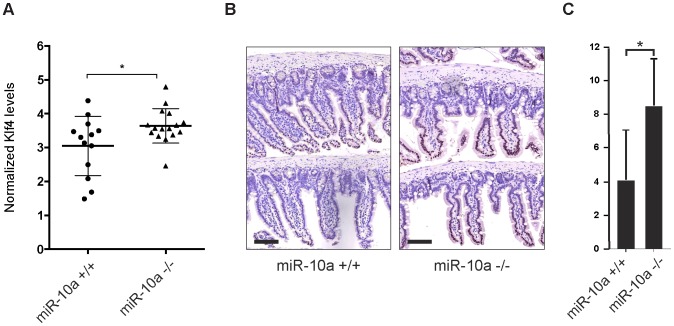
Klf4 is upregulated in miR-10a KO intestines.(A) mRNA levels of Klf4 were measured by qRT-PCR, Actb, Ubc, Hprt and 36b4 were used for normalization. Data are shown as mean ± S.D. of miR-10a KO (n = 16) and WT (n = 13) samples relative to an average of the controls. * p<0.05 using a Mann-Whitney test. (B) Representative immunohistochemistry staining of Klf4 in miR-10a WT (n = 5) and KO (n = 8) intestine. Scale bar 100 µm (C) VisiomorphDP software scoring of Klf4 expression level estimated by distribution and staining intensity in Klf4 stained intestines of WT and miR-10a KO mice. * p = 0.019, students t-test.